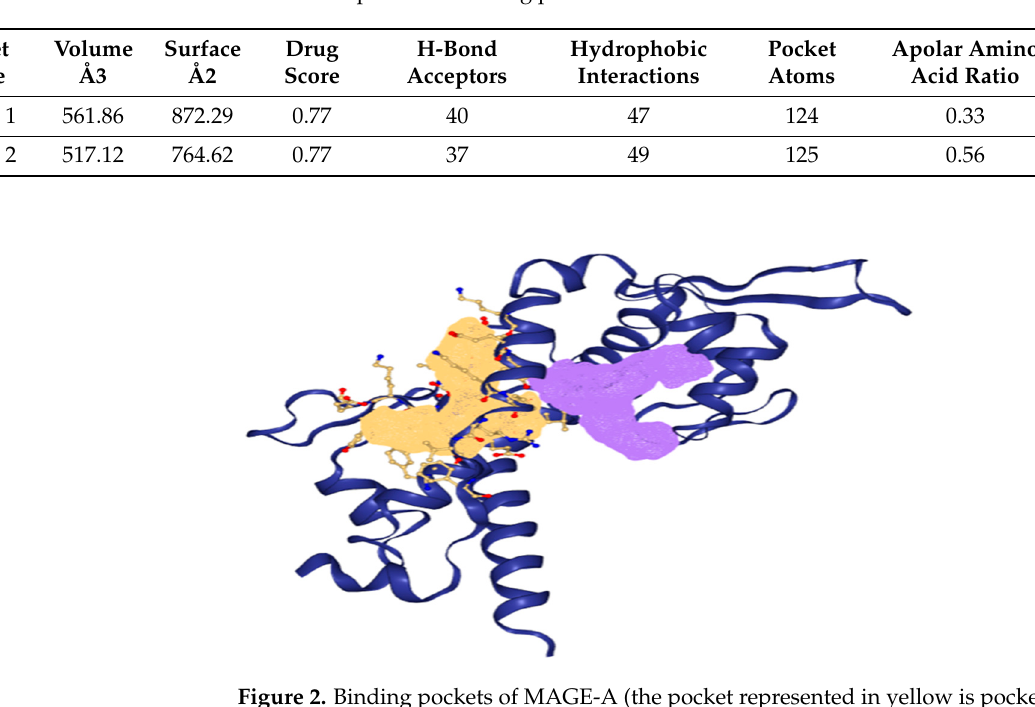
Figure 2 . Binding pockets of MAGE-A (the pocket represented in yellow is pocket 1, and the pocket represented in purple is pocket 2) .